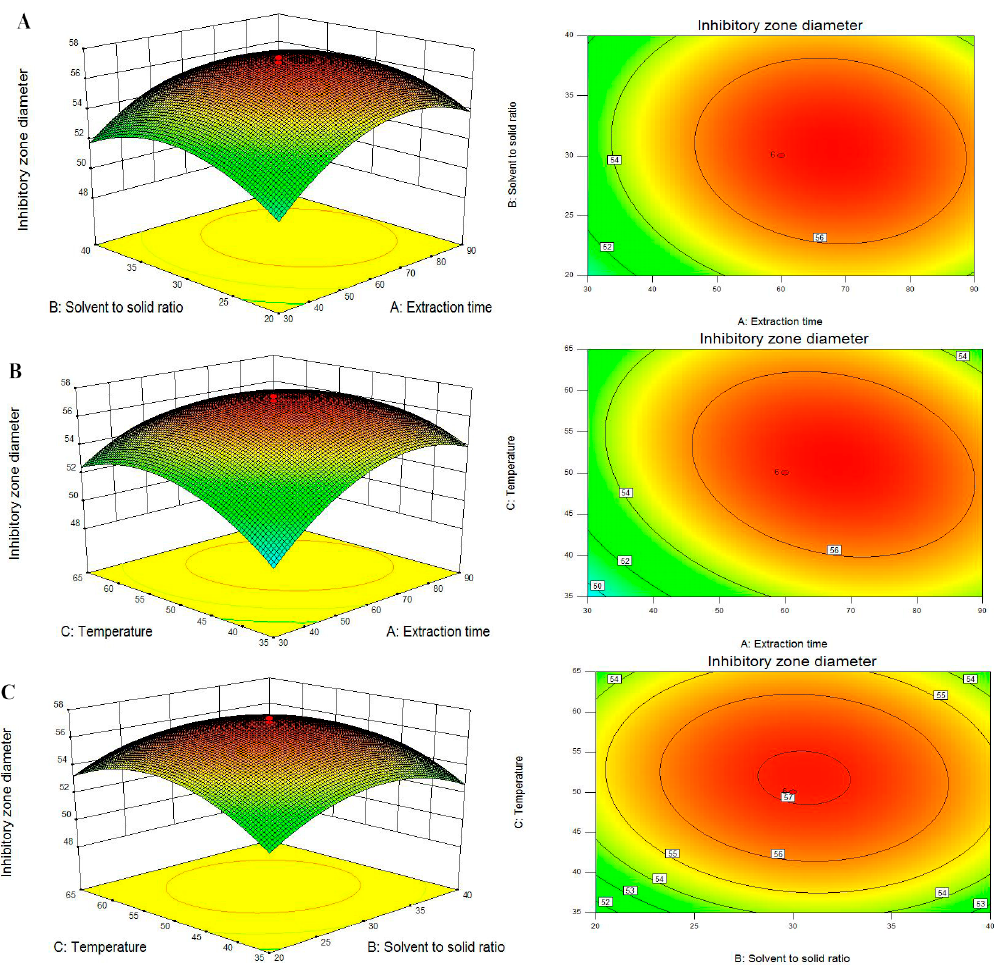
Figure 3. Response surface plot and contour plot showing DIZs against P. italicum of extraction time and solvent to solid ratio ( A ); extraction time and temperature ( B ) and solvent to solid ratio and temperature ( C ).